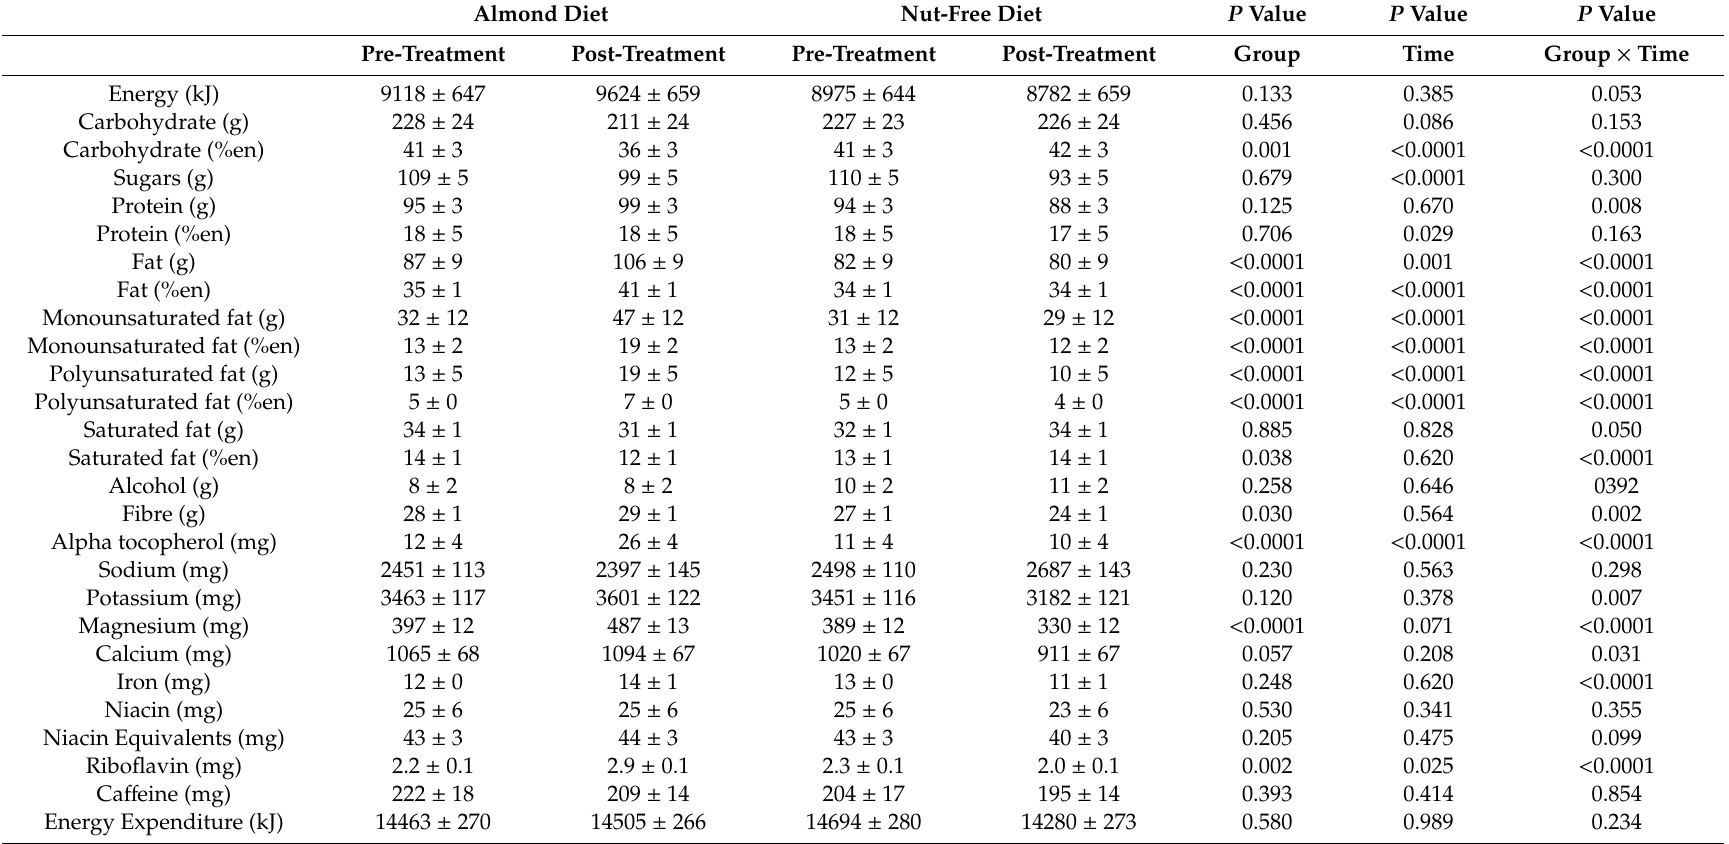
Table 2. E ff ect of treatment on dietary nutrient intake and energy expenditure as determined weighed food diaries and activity diaries. Almond Diet Nut-Free Diet P Value P Value P Value Pre-Treatment Post-Treatment Pre-Treatment Post-Treatment